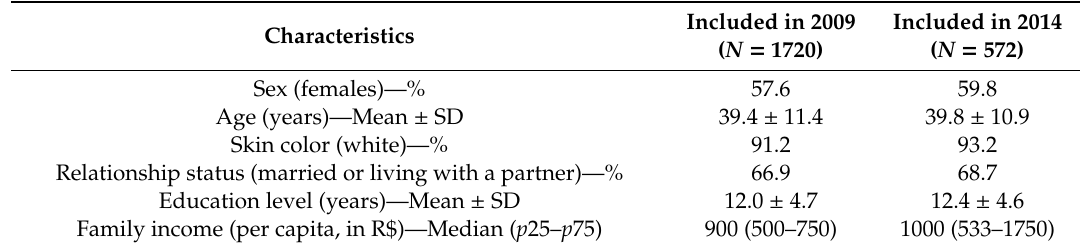
Table 1. Comparison of the sample characteristics between baseline (2009) and the follow-up in 2014 a